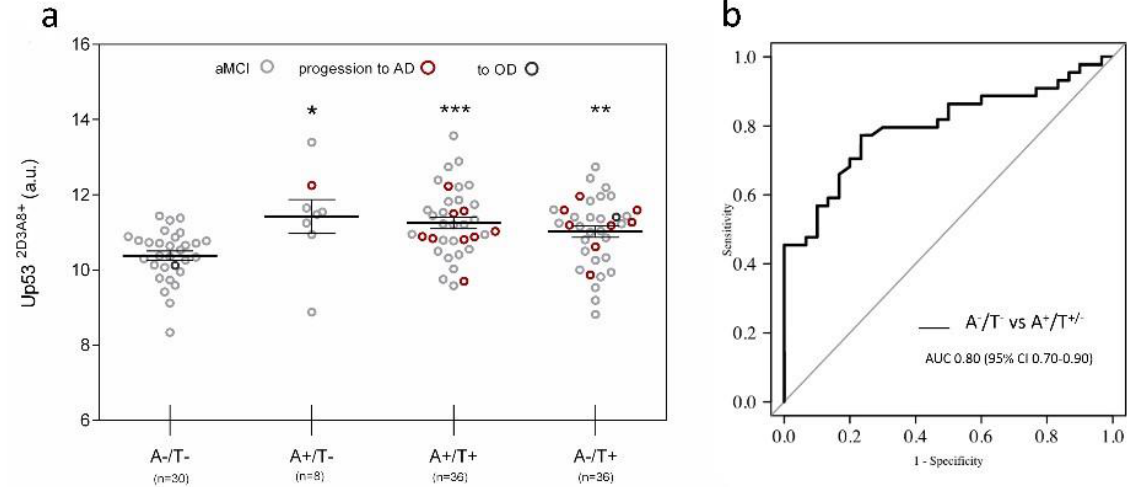
Figure 4. U-p53 2D3A8+ in PharmaCog/E-ADNI subjects stratified according to CSF markers. Subjects were stratified using a multimodal classification scheme with CSF A β 42 (A) and p-Tau (T) cutoff reported in the literature. ( a ) Scatter dot blots report the value of U-p53 2D3A8+ in the different groups. The results obtained are represented as mean ± SEM. Red circle: aMCI to AD, dark gray circle: aMCI to other dementia. After a period of 6 to 30 months, 91 patients remained stable aMCI, apart from 1 who developed mixed AD + DLB dementia at 24 months (in the group A − /T − ), 1 who progressed to DLB at 12 months (in the group A − /T + ), and 18 who progressed to AD in a range of 6 to 30 months (9 in the A + /T + group, 1 in the A + /T - group, and 8 in the A − /T + group). Wilcoxon test adjusted for multiple comparison: A − /T − vs. A + /T – ( p < 0.05 *); A + /T + ( p < 0.001 ***) and A - /T + ( p < 0.01 **). One patient had missing CSF information. ( b ) ROC curve was used to distinguish A − /T − versus those subjects with A β —positive status (A + /T +/ − ) with an AUC of 0.80. Additional information on the performance of U-p53 2D3A8+ in discriminating these groups is reported in Figure S11. Results were extrapolated from a short-reference peptide standard curve and are expressed as arbitrary units